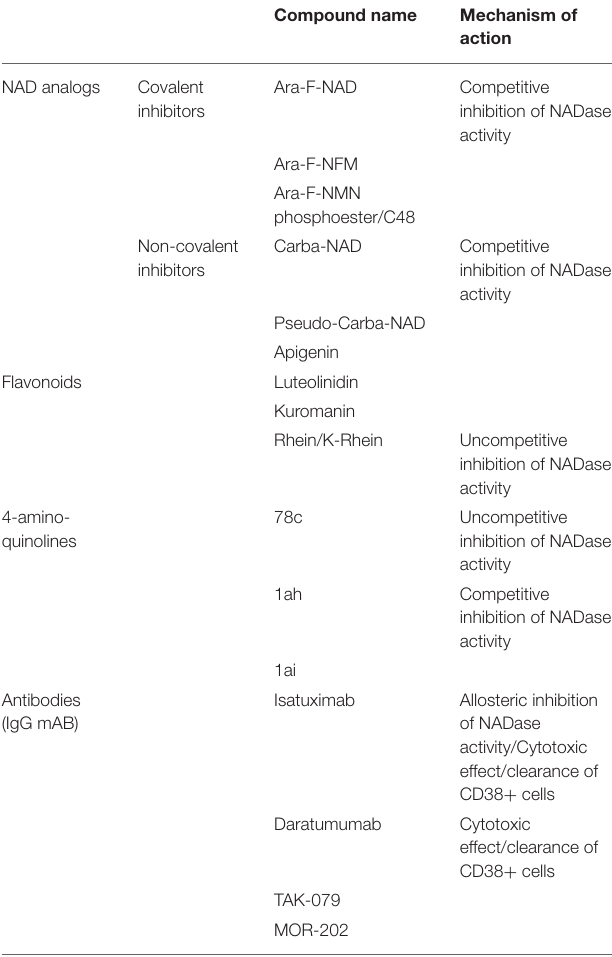
TABLE 1 | Therapeutic approaches to CD38 inhibition and